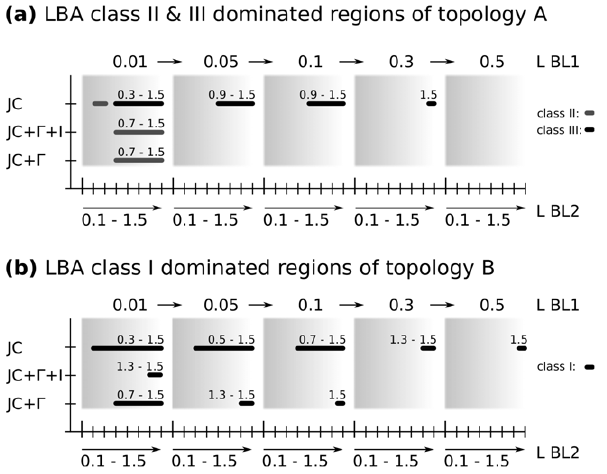
Figure 3. Selected results of ML reconstuctions for a ~ 1 : 0 under the mixed-distribution model (JC + C + I) and the C distributed model (Jukes-Cantor + C ). Class III (‘‘Felsenstein effect’’), Class I (attraction due to symplesiomorphies), and Class II (random error probably due to signal erosion) inferred from 100 simulation repeats for each branch length combination and alignment length. Each individual plot corresponds to a fixed branch increase of BL 1 ~ 0 : 01 (Figure 2) and fixed reconstruction scheme with the models JC + C ( a ~ 0 : 1 ) or JC + C + I ( a ~ 0 : 1 ; r inv ~ 0 : 3 ). Branch length differences increase from left to right by increasing branch BL 2 in discrete elongation steps (0.1–1.5). Four successive data points (belonging to one cell in the plot) correspond to four alignment lengths (2,000, 3,000, 4,000, 10,000 base pairs). Alignment corresponding branch lengths of BL 2 are shown above each subfigure. The y-axis depicts the reconstruction success of the 100 simulation repeats (N) for a) Topology A (Figure 2a) and b) Topology B (Figure